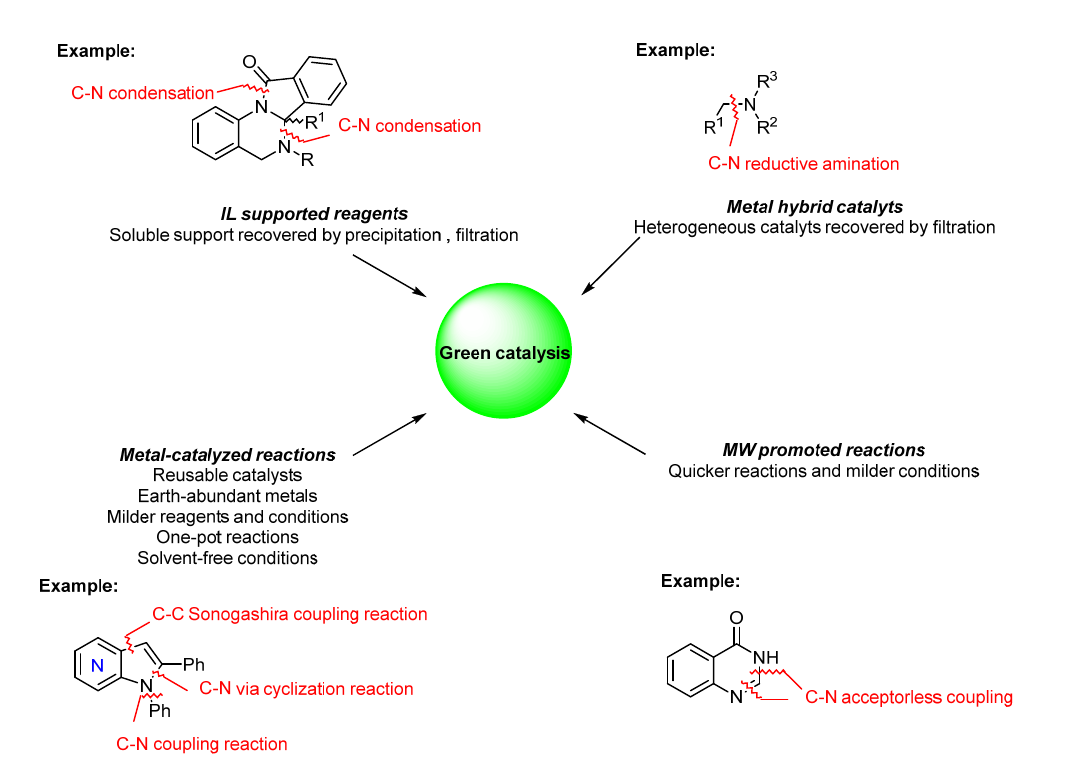
Figure 2. Examples of the green catalysis methods reviewed herein.